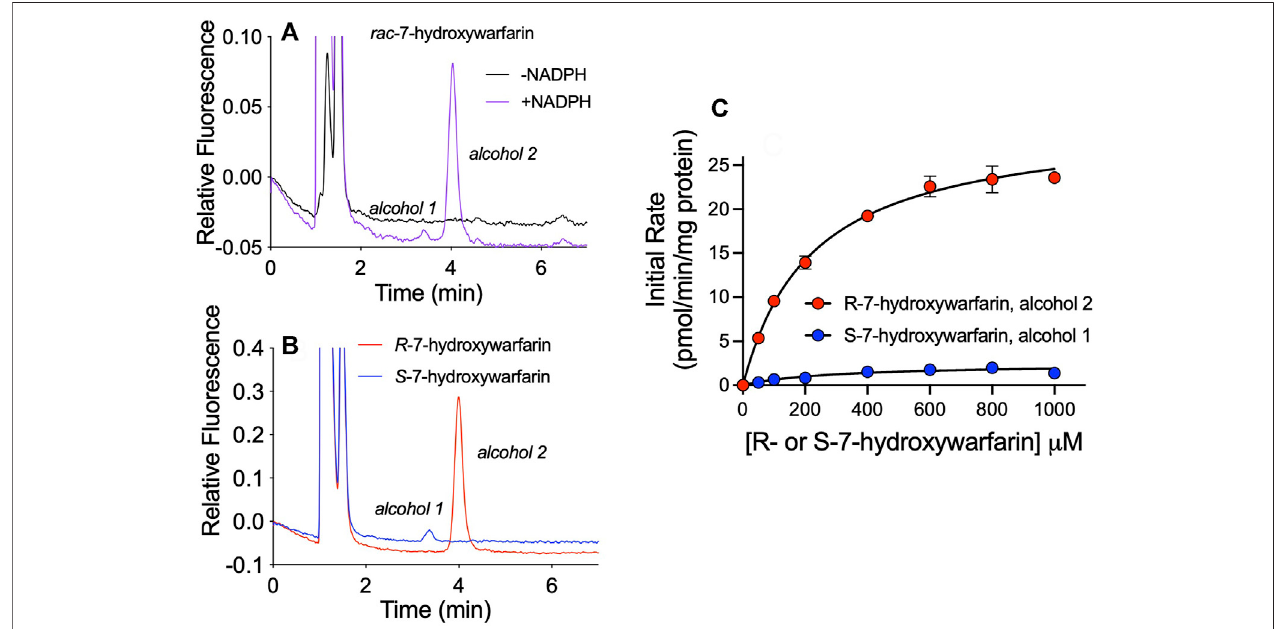
FIGURE 7| Enantioselective and enantiospeci fi c metabolism of R- and S-7-hydroxywarfarin. An exploration of the impact of chirality on hydroxywarfarin reduction carried out with chromatographically puri fi ed 7-hydroxywarfarin enantiomers. (A) As a baseline for comparison, chromatographic analysis of 200 μ M rac -7- hydroxywarfarin reduction (100 μ Mofeach enantiomer) using 1.0 mg/ml protein humanlivercytosol in50 mMpotassiumphosphate pH7.4intheabsenceorpresence of NADPH. (B) Chromatographic analysis of the reduction of 100 μ M of either R -7-hydroxywarfarin (red) or S -7-hydroxywarfarin (blue) under the same reaction conditions. (C) Steady-state kinetics were carried out with the same reaction conditions but varying concentrations of substrate. Plots of initial rates as a function of 7- hydroxywarfarin concentration were fi t to the Michaelis-Menten mechanism for R -7-hydroxywarfarin (red, alcohol 2) or S -7-hydroxywarfarin (blue, alcohol 1). The corresponding kinetic constants are reported in Reductases Showed Chiral Preferences in R- and S-7-Hydroxywarfarin Reductions under